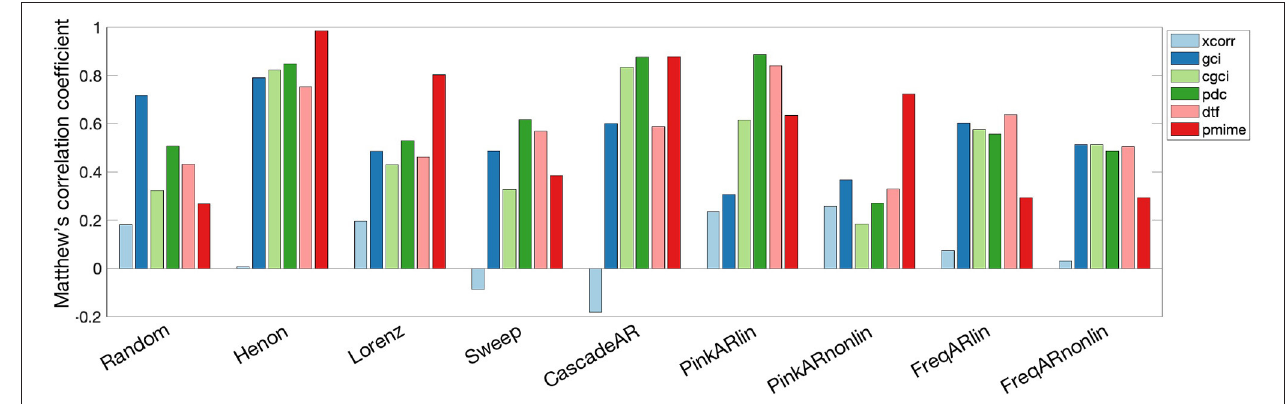
FIGURE 4 | Bar graph showing the performance of the causality measures on each simulation model separately. The measures are computed on 100 iterations of each simulation model and performance is quantified by the MCC values.